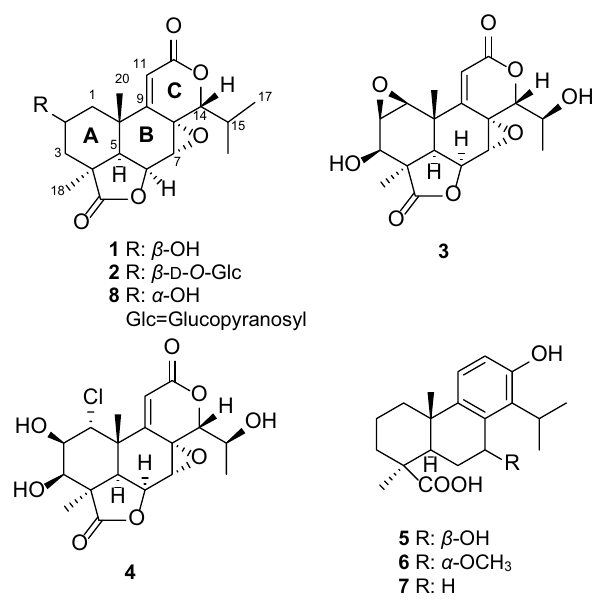
Fig. 2 Structures of isolated compounds ( 1 – 8